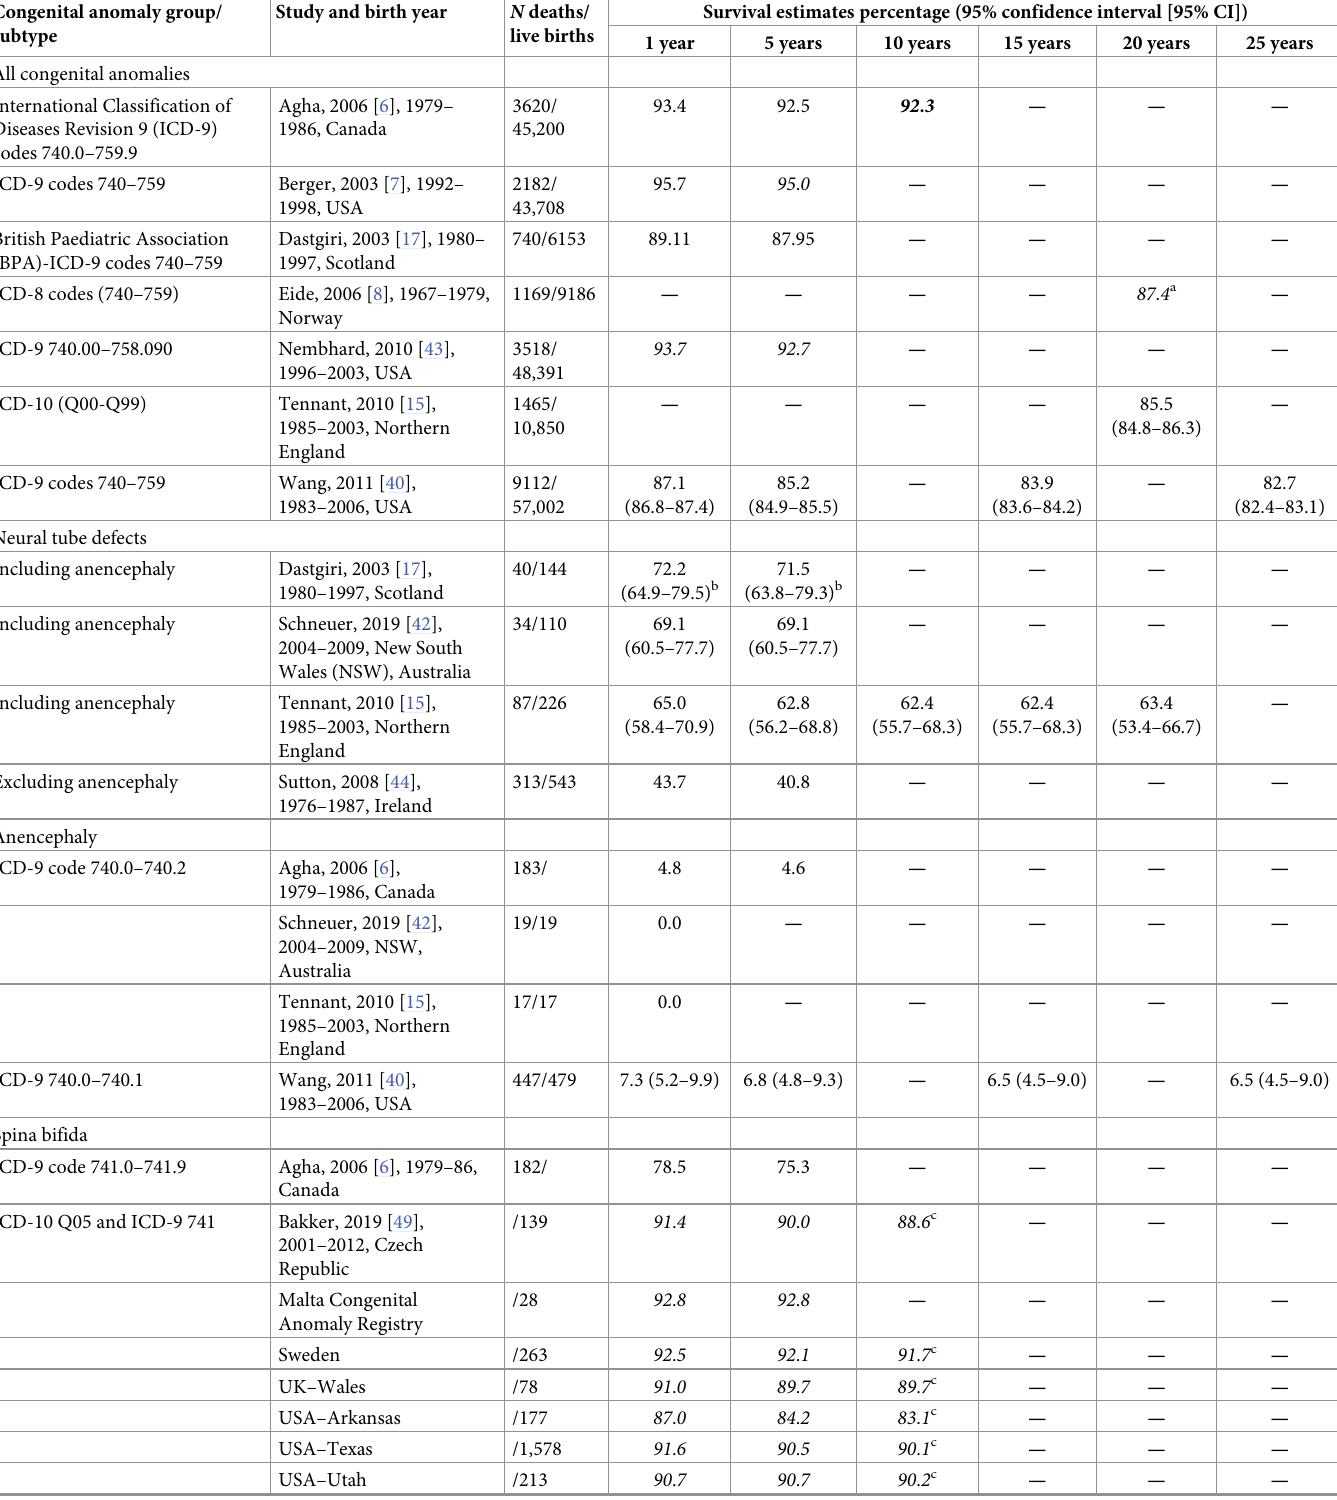
Table 2. Survival estimates by congenital anomaly type at age 1–25 years, overall and by birth